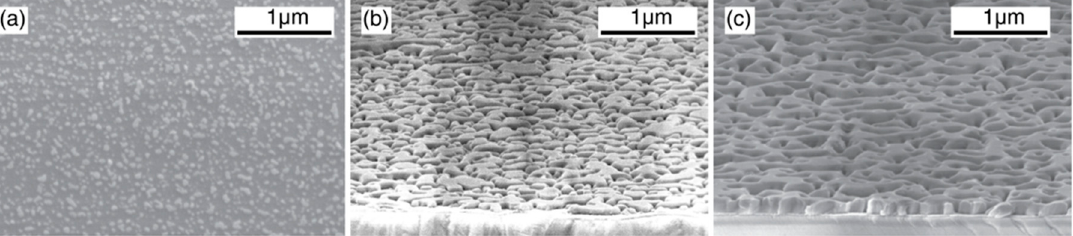
Figure 6. SEM images of the grown samples at 5 min ( a ), 6 min ( b ), and 7 min ( c ). Reprinted with permission from [37]. Copyright (2019) American Chemical Society.